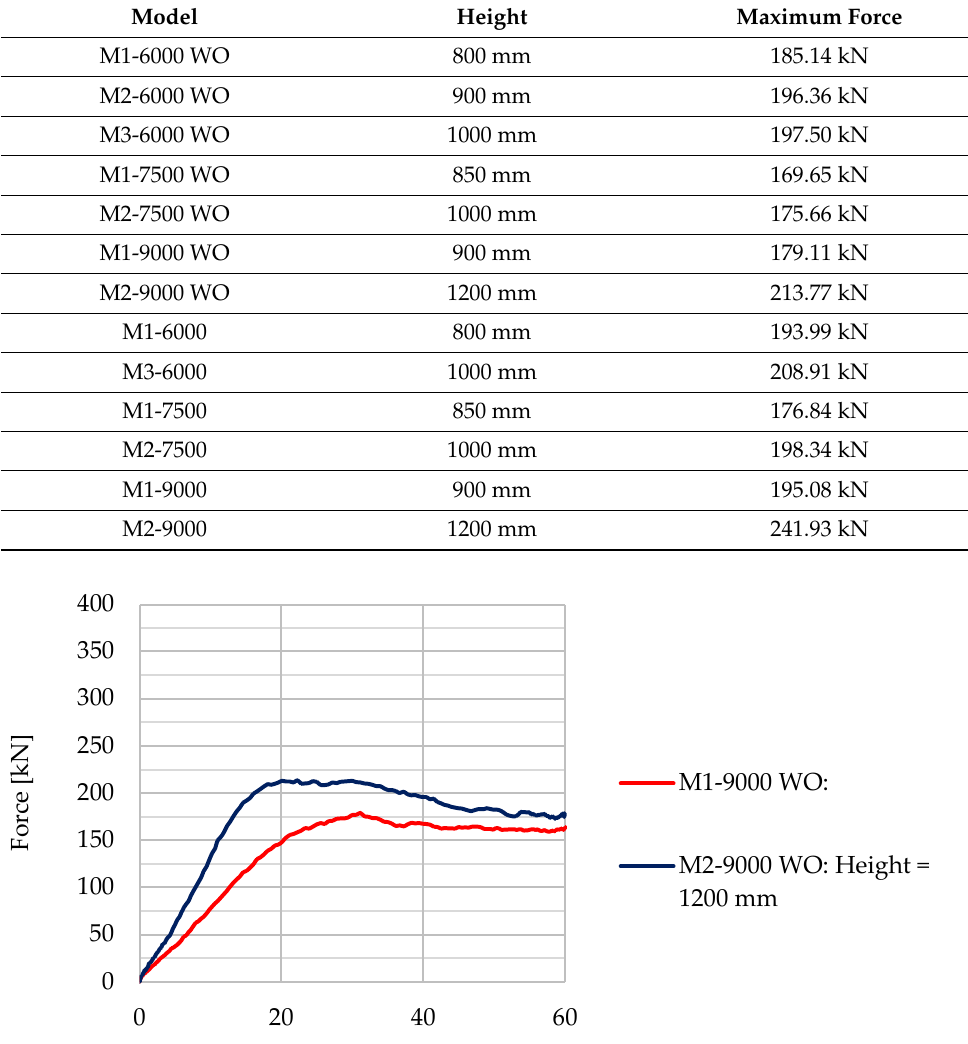
Table 2. Bearing capacity of the CWB beams for different heights.